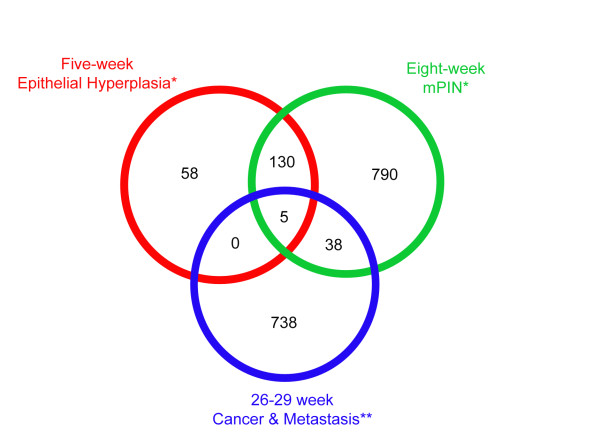
Overlap of PTEN signature genes (restricted to those with a Unigene designation) changed after 5 and 8 weeks and after 26-29 weeks. *this study; **data from Wang et al. (2003).